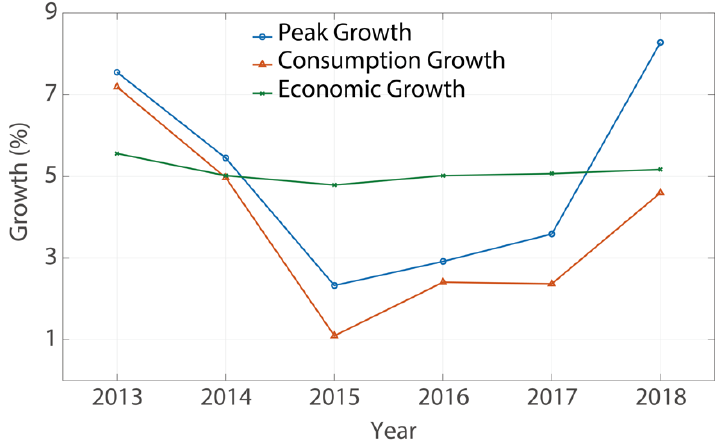
Figure 1. Comparison of power consumption, peak load and economic growth.